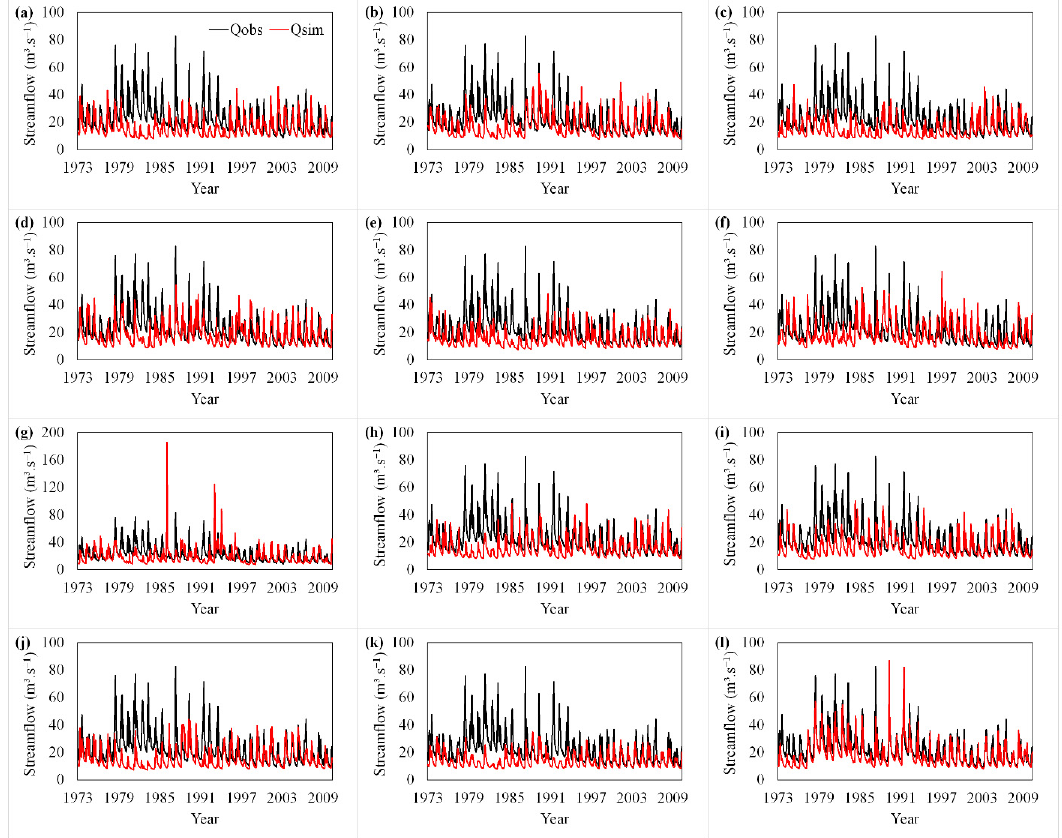
Figure 3. Hydrological validation with the ten ERA-20CM ensemble members ( a – j ), AE ( k ), and the ERA5-Land ( l ) from August 1973 to December 2010 to PRB. Table 5. Statistical results of hydrological validation with the ten ERA-20CM ensemble members, the AE, and the ERA5-Land from August 1973 to December 2010 in monthly time scale to PRB.